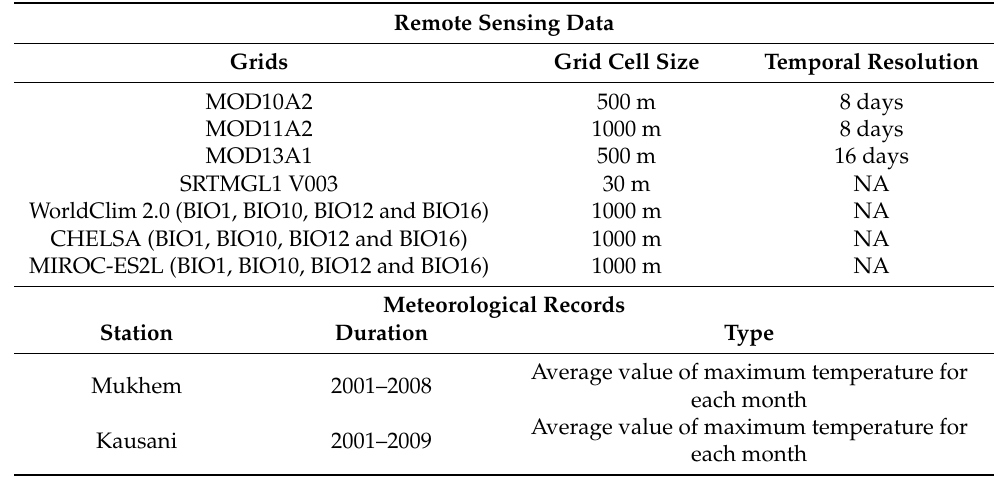
Table 1. Summary of the remotely sensed data and field-based observations used in this study (NA refers to not applicable). Remote Sensing Data Grids Grid Cell